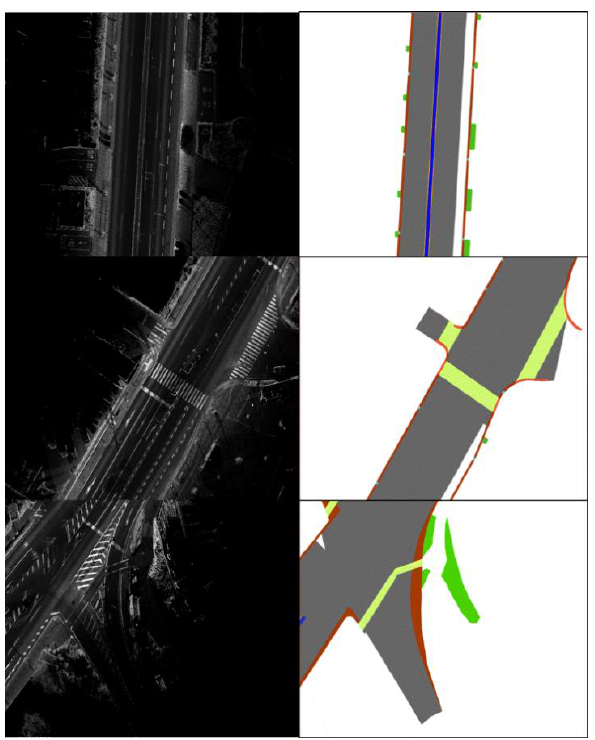
Figure 4. Example of our dataset. Left: LIDAR intensity image, Right: Ground truth label